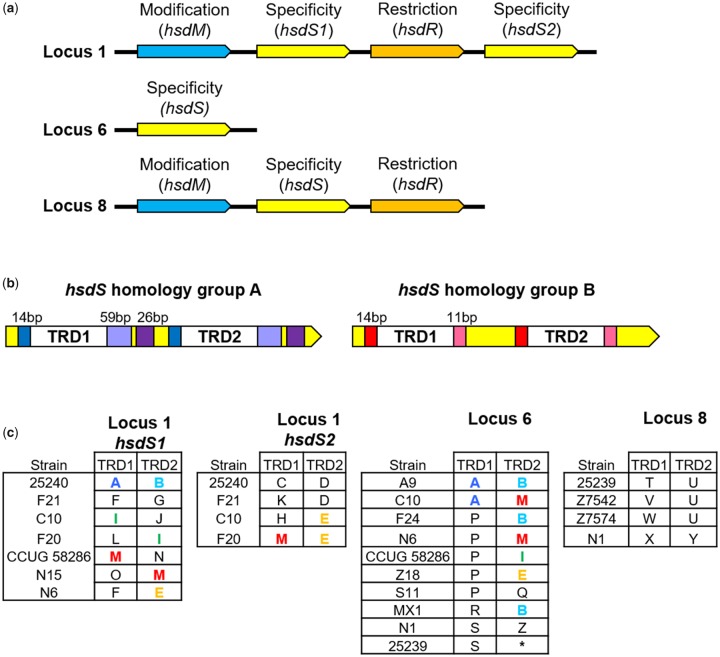
—Schematic of variable hsdS target recognition domains (TRDs) of Type I DNA methyltransferases. (a) Schematic representation Type I R-M systems at loci 1, 6, and 8, indicating the arrangement of their modification, specificity and restriction endonuclease subunit genes. (b) Sequence organization of hsdS genes belonging to homology group A and homology group B. Colored boxes adjacent to the two variable TRDs (TRD1 and TRD2) indicate repeated sequences within a hsdS gene, at which homologous recombination may occur, mediating domain movement of TRDs. (c) Variable TRDs present within the hsdS genes of the complete Type I R-M systems (locus 1 and locus 8) and the orphan hsdS gene (locus 6) are shown. Each of the 26 unique TRDs are assigned a letter (A–Z) and representative strains possessing each TRD are shown. Colored letters indicate TRDs that have undergone domain movement and are found at more than one locus. *No TRD is present due to a truncated hsdS gene.